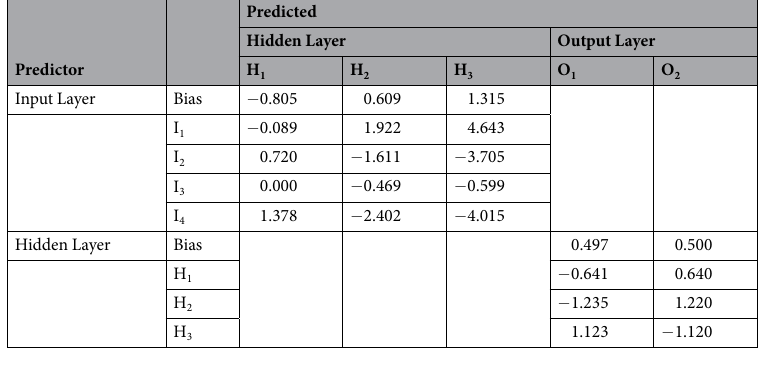
Table 4. Parameter